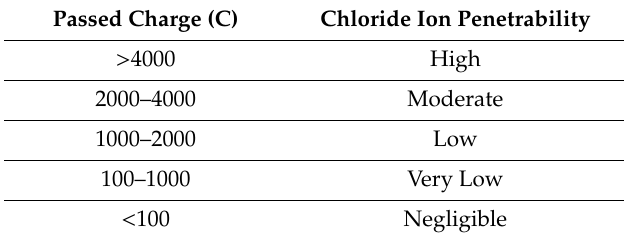
Table 7. Evaluation criteria for chloride ion penetration resistance